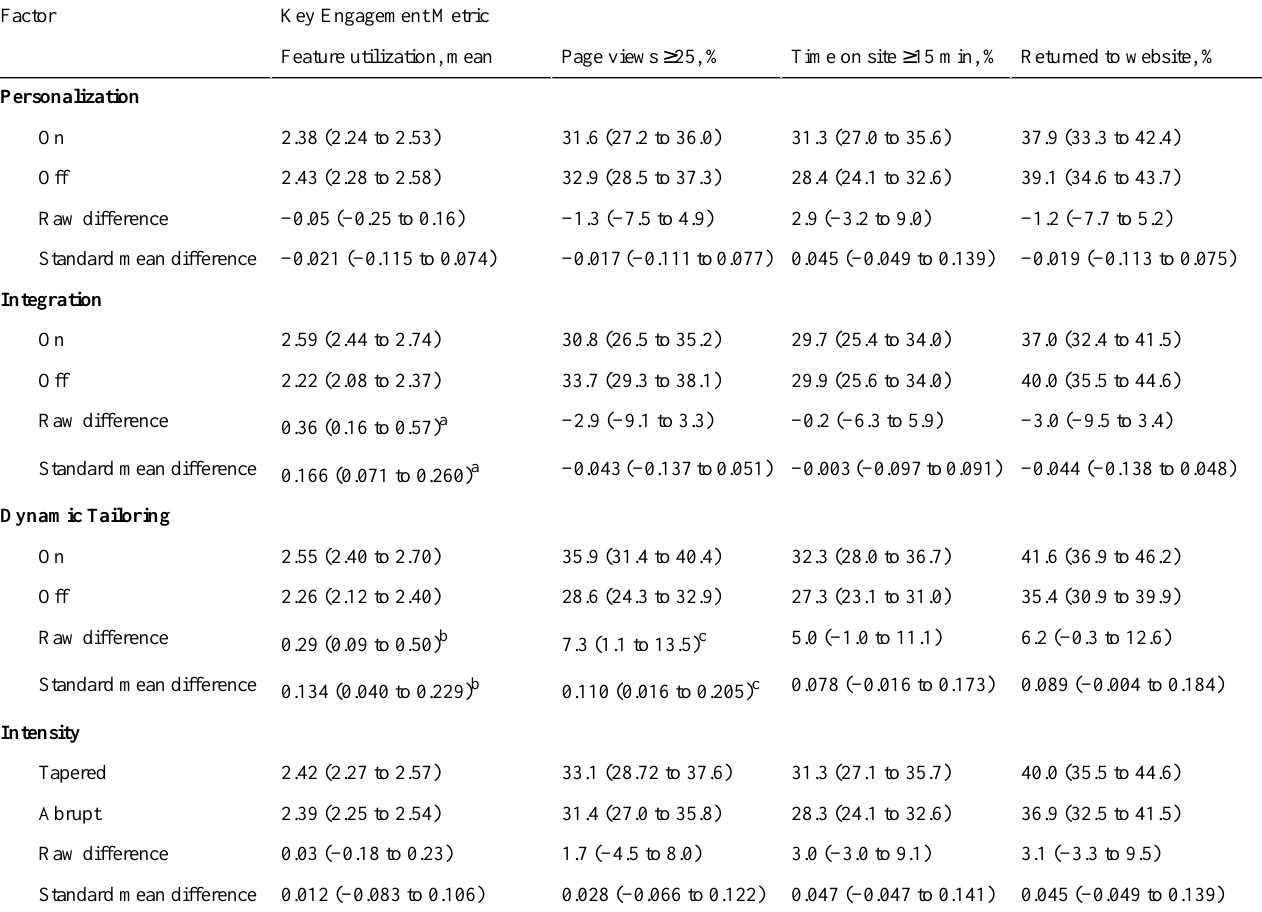
Table 2. Marginal effects of experimental design factors on key engagement metrics (95% CI). Key Engagement